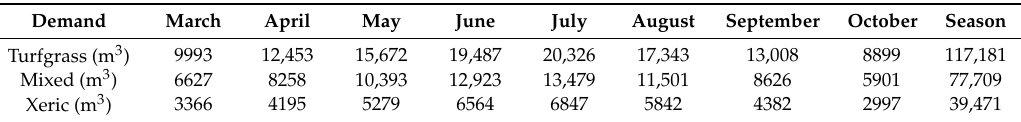
Table 5. Water demand for di ff erent landscaping types in Colorado’s Front Range region. Volumes are based on the example development in Table